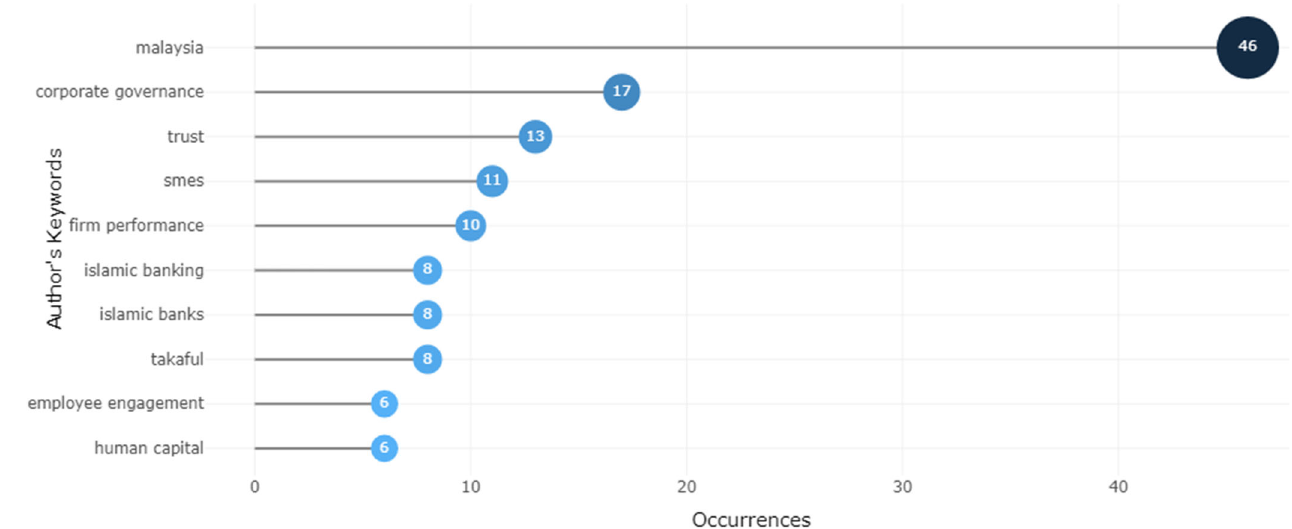
Figure 5. Top 10 most frequent author keywords in Jurnal Pengurusan .